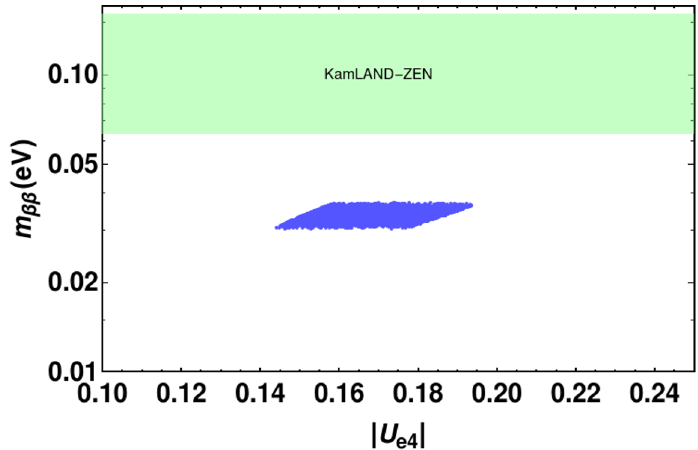
Figure 5 . The prediction of the e(cid:11)ective neutrino mass, m (cid:12)(cid:12) , in relation to the active-sterile mixing